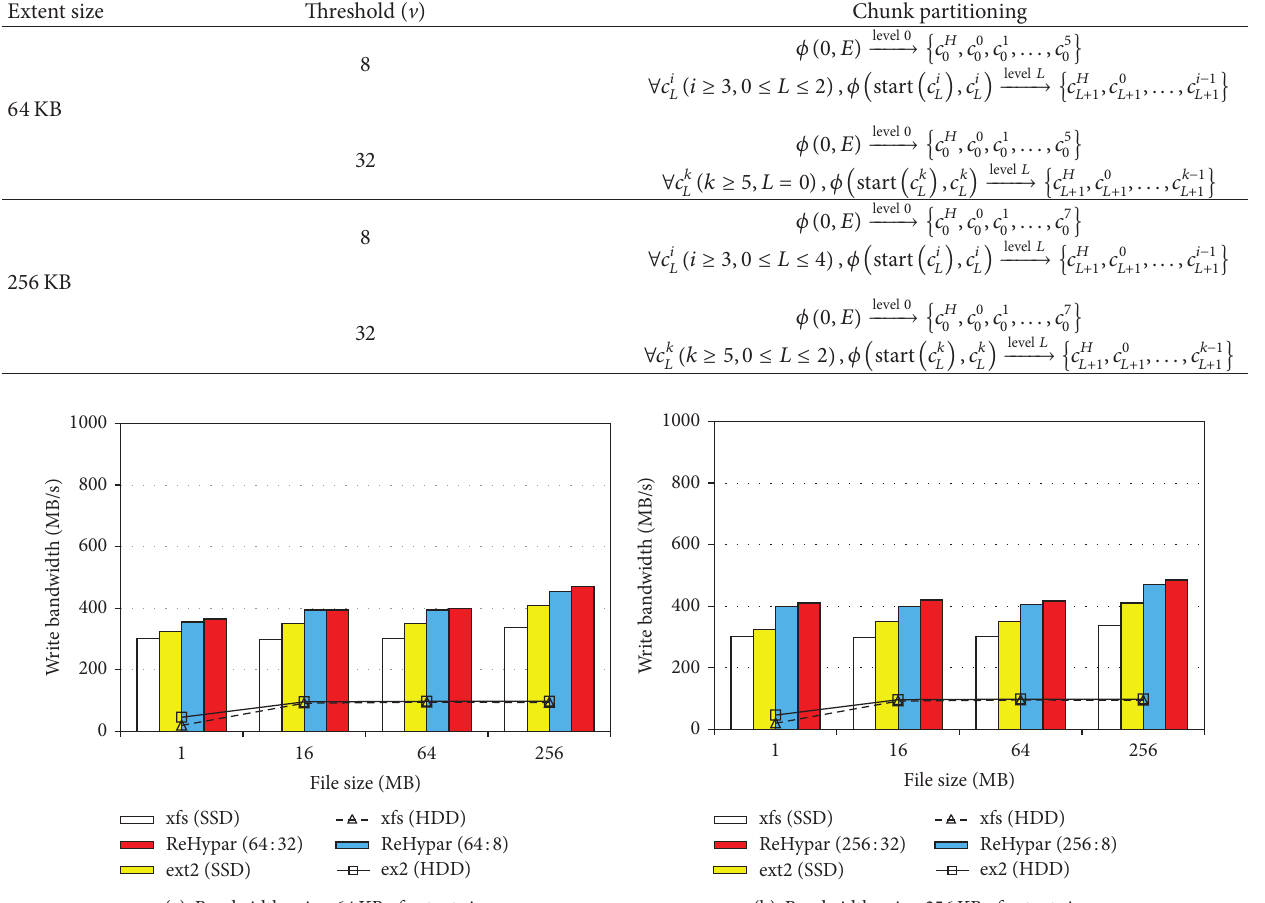
Table 1: Extent structure based on threshold ( v ).